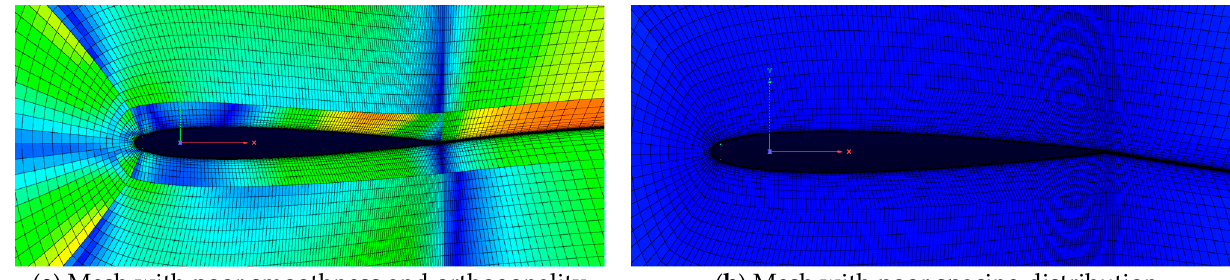
Figure 14. The results of the mesh samples in the dataset are visualized using the traditional quality metric. ( a ) Gridformer is able to identify poorly orthogonal and poorly smooth mesh in agreement with the traditional quality metric. ( b ) A poorly spaced distribution mesh, but not identified by the traditional quality metric, is accurately classified by Gridformer.